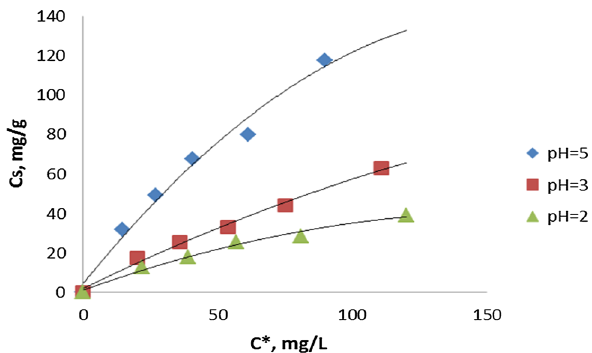
Fig. 3 Effect of pH on equilibrium distribution of cadmium metal ion (298 K; 0.091 g/50 mL)